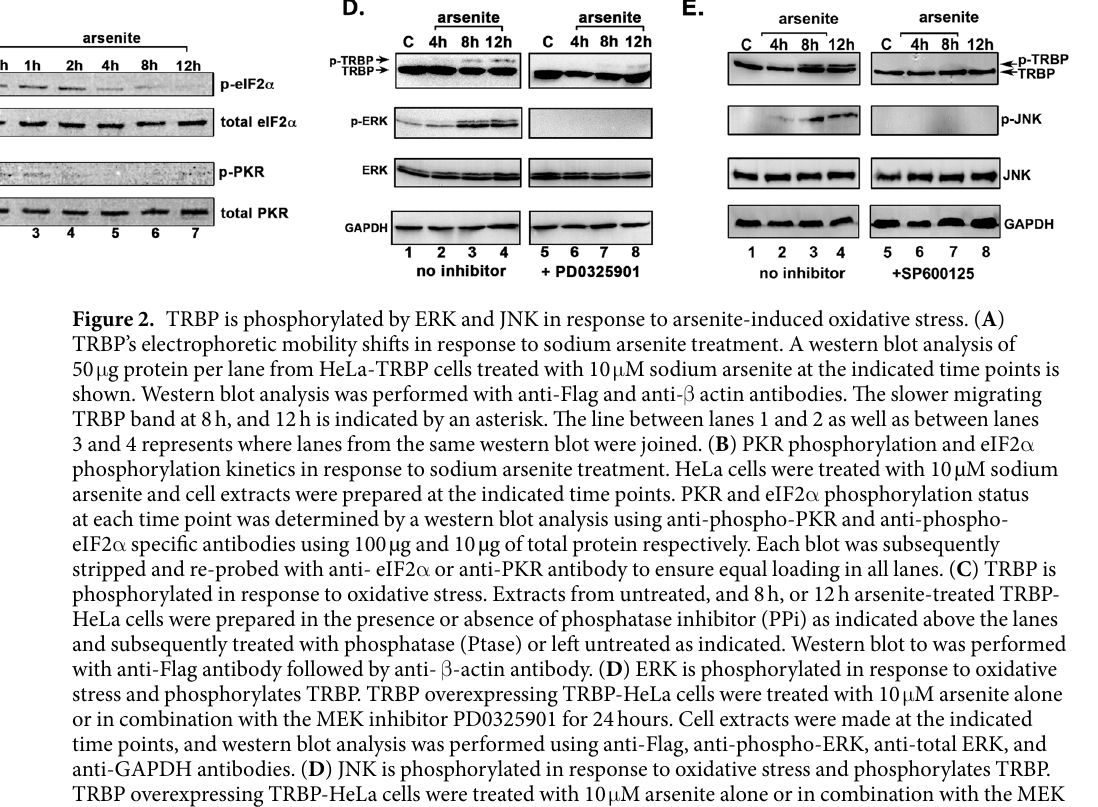
Effect of TRBP phosphorylation on cellular response to stress. Having demonstrated that TRBP is phosphorylated by JNK and ERK 1/2 in response to oxidative stress, we wanted to determine how TRBP phos- phorylation affects the oxidative stress and PKR-mediated cellular apoptosis. To evaluate the involvement of phosphorylation, we generated a phospho-defective TRBP point mutant (TRBP AAAA) which contains alanine for serine substitution at 4 sites (S142, S152, S283, S286) previously identified as MAPK/ERK 1/2 substrate sites 34 . Of these sites, S142 and S152 have also been previously shown to be phosphorylated by JNK 33 . A phospho-mimic TRBP point mutant (TRBP DDDD) was also generated by substituting aspartic acid for serine at the same four sites (Fig. 3A). To examine the effect of TRBP phosphorylation on oxidative stress-induced apoptosis, we transfected HeLa cells with each TRBP phospho-mutant as well as wt TRBP and observed changes in the induction of apoptosis in response to oxidative stress. As seen in Fig. 3B, the cells transfected with the empty vector (EV) alone showed 5.6% apoptosis (Untreated, black bar) in the absence of stress which increased to 46.9% at 24 after sodium arsenite treatment (24 hrs, black bar). The DDDD TRBP phospho-mimic mutant showed significantly reduced apoptosis in response to oxidative stress with only 29.1% cells undergoing apoptosis at 24 h after treatment (24 hrs, red bar). Statistical analysis also showed a significant difference between the % apoptosis in the cells expressing the empty vector as compared to the cells expressing the TRBP phospho-mimic mutant, indicating that TRBP phosphoryla- tion does have a protective effect on cells during oxidative stress. Analysis of the % apoptosis in the cells express- ing the AAAA TRBP phospho-defective mutant to that of cells expressing EV showed no statistical difference (24 hrs, blue bar), highlighting the importance of phosphorylation for TRBP’s anti-apoptotic activity. The cells overexpressing the wt TRBP showed 34.3% apoptosis, which is more compared to the cells overexpressing DDDD TRBP, but less than the cells overexpressing AAAA TRBP. This suggests that the wt TRBP overexpression allows for higher amounts of phospho-TRBP than the levels with endogenous TRBP in EV transfected cells, thus making it more effective that AAAA TRBP in preventing prolonged phosphorylation of eIF2 α and apoptosis.